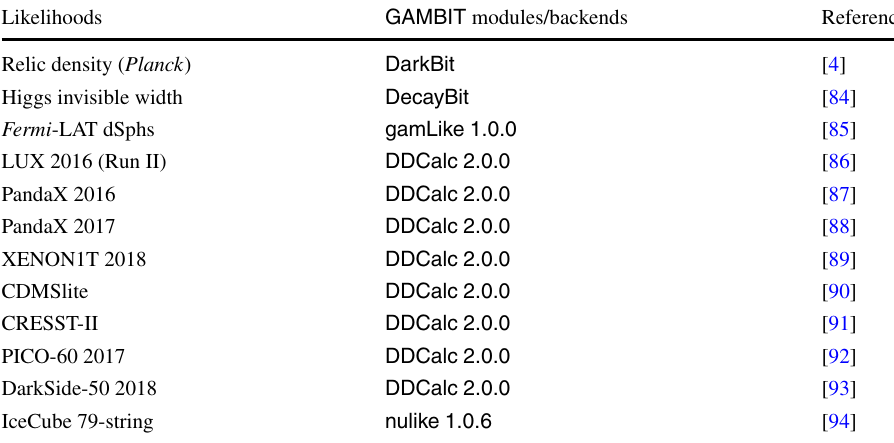
Table 1 Likelihoods and corresponding GAMBIT modules/backends employed in our global